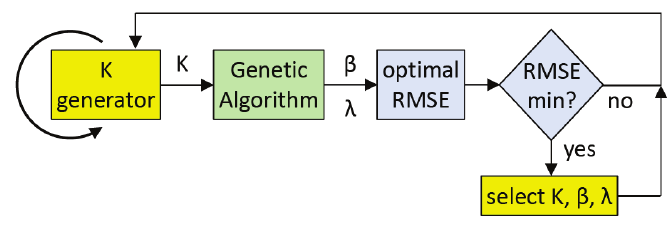
Figure 5. GAK method: combination of a K loop and GA for optimizing the pair ( β , λ